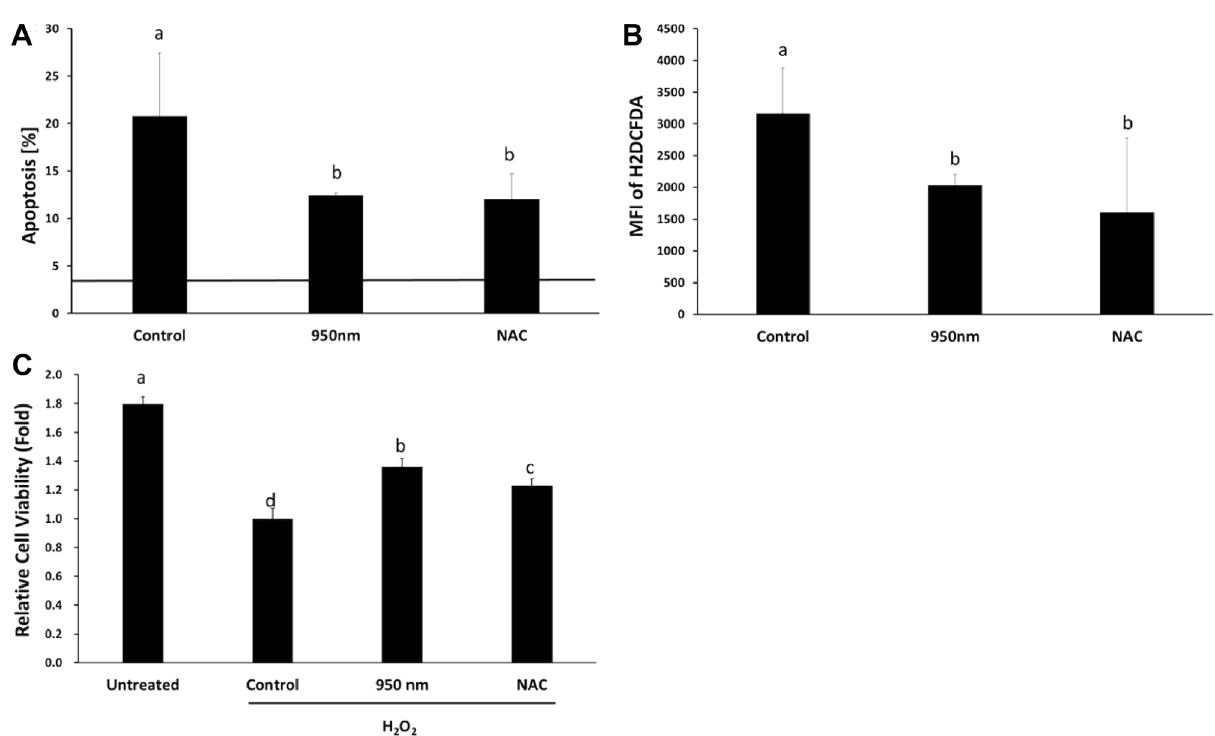
Figure 3. Irradiation with 950 nm NIR reduced apoptosis and ROS as NAC. ( A ) Apoptotic cell rate. The solid line on the graph is the results of the non-cryopreserved group. ( B ) MFI of H2DCFDA. ( C ) Relative viability of cells with hydrogen peroxide. The reduction of viability was alleviated by 950 nm NIR and NAC treatment. Data are mean ± SD (n > 5). Different letters at the tops of columns are significantly different at P < 0.05 according to Duncan’s